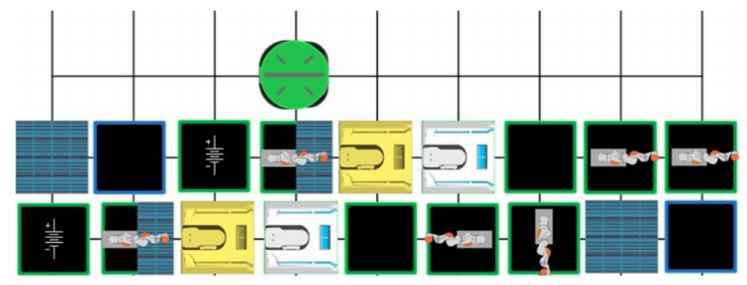
Figure 4. Multi-row random layout of modular platforms.